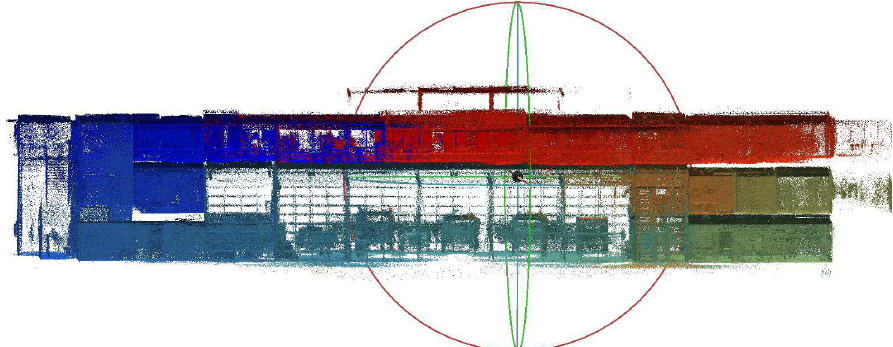
Figure 4. Dataset of indoor office environment for evaluation of ZEB-1 scanner [4]. In the experiment, 3.8 cm error of corner-to-corner average distances within the rooms was